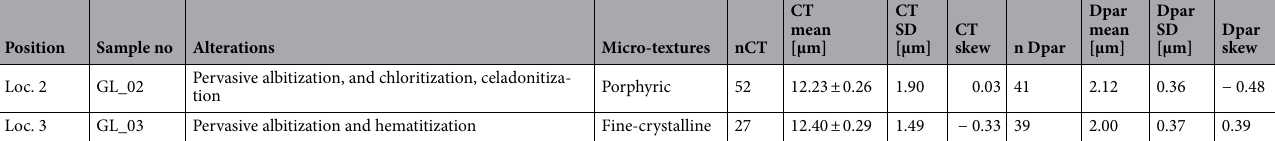
Table 9. Apatite fission-track length and Dpar (mean etch-figure diameter parallel to the c axis) data for the samples collected from various areas of the Głuszyca trachyandesite laccolith. Note the sample from Loc. 1 was excluded due to insufficient amounts of confined tracks. nCT—number of measured confined tracks; CT mean—mean confined track length; SD—standard deviation; CT skew—skewness of distribution relative to the mean value (measure of asymmetry of the distribution); n Dpar—number of etch pit diameters measured; Dpar mean: mean etch pit diameter; Dpar SD—standard deviation of etch pit diameters; Dpar skew: skewness of etch